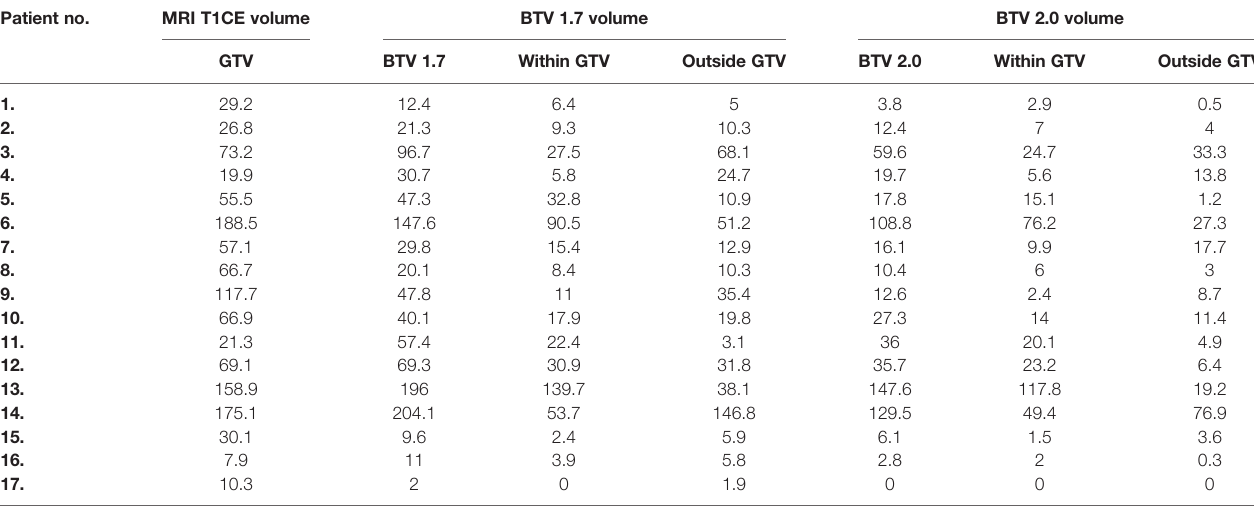
TABLE 2 | The MRI T1CE GTV; BTV 1.7 and BTV 2.0 and the relation between measured volume (overlap/difference) values are shown in cm 3 . Patient